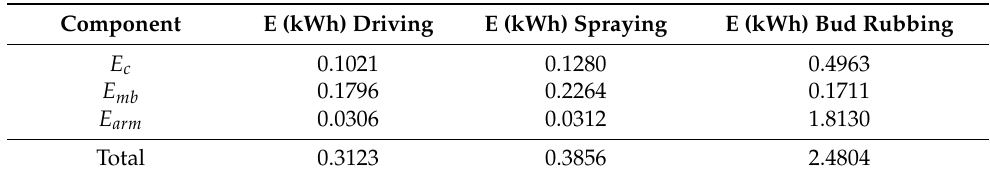
Table 4. Estimated energy consumed by different systems during vineyard navigation, spraying and bud rubbing.